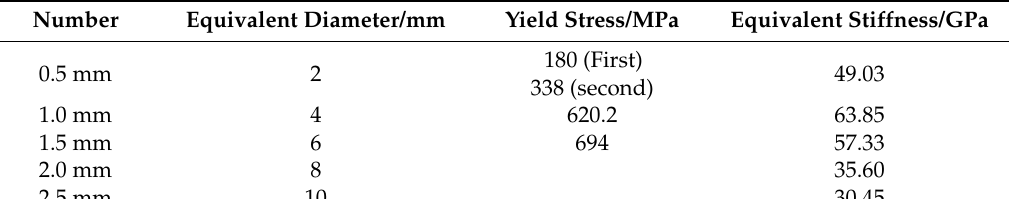
Table 5. Calculation results of compression tests.